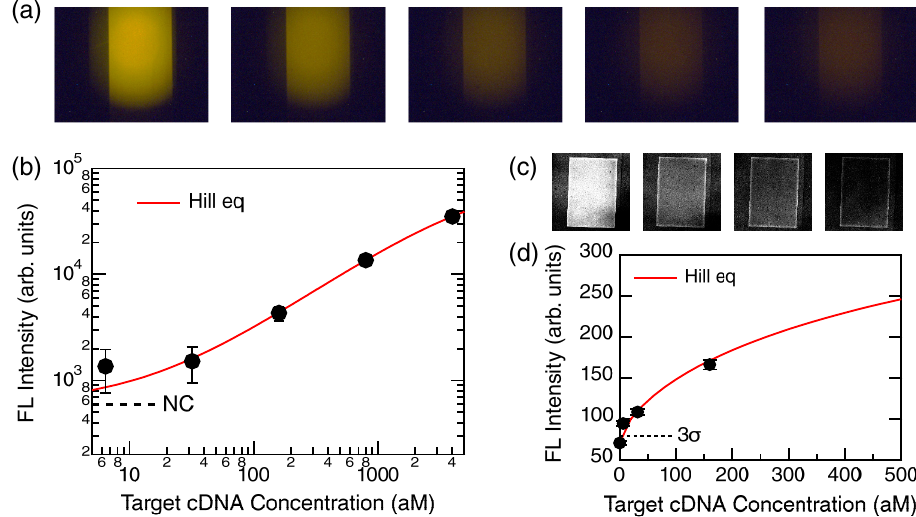
Figure 4. PCR results. ( a ) FL images at target concentrations of 4000 aM, 800 aM, 160 aM, 32 aM, and 6.4 aM, shown from left to right, respectively. The images were taken in the automated system (Section 2.4). ( b ) Log–log plot of FL intensity (black closed circle with error bar) for the target concentrations. The data were fitted using the Hill equation (red, Equation (2)). Dashed line indicates the NC (or 0 M) level. ( c ) Confocal FL images: target concentrations at 160 aM, 32 aM, 6.4 aM, and 0 M from left to right, respectively. Each image is a square shape of 1.1 mm side. ( d ) A magnified view of the confocal FL-intensity plot near 0 M, which is presented in a linear manner. Fitted curve using the Hill equation is shown with red. The 3 σ level from the background level at 0 M is shown with dotted